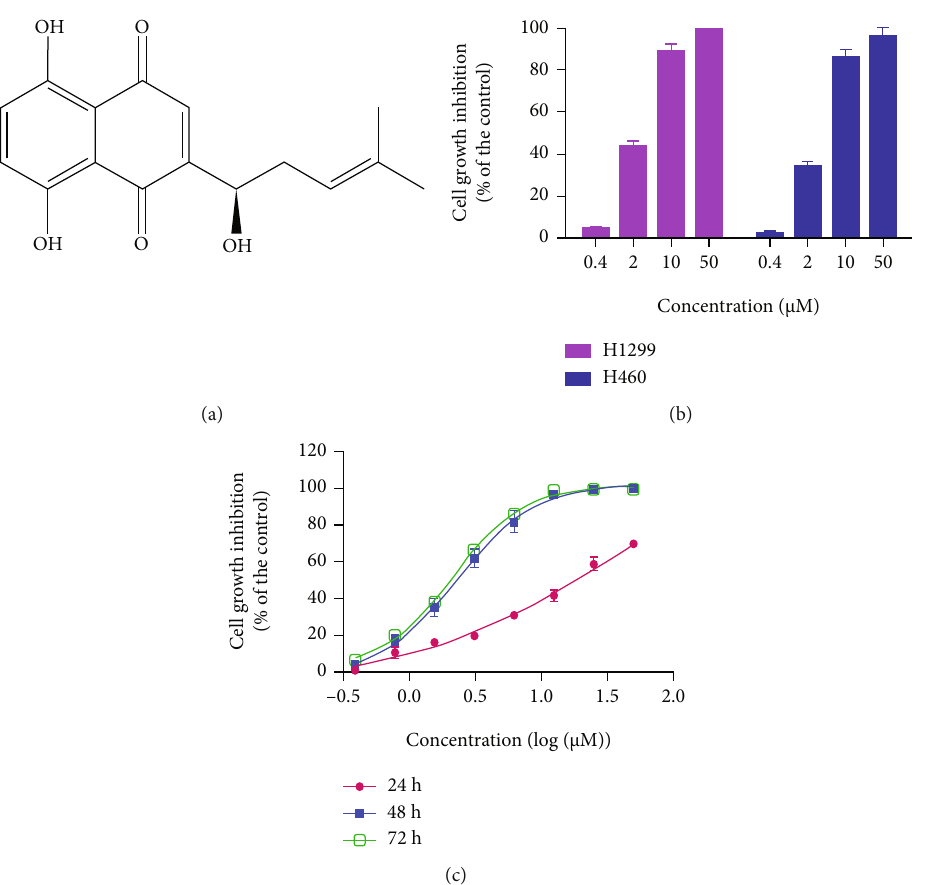
Figure 1: The e ff ect of shikonin on NSCLC cell growth: (a) chemical structure of shikonin; (b) e ff ect of shikonin on NSCLC cell (H1299 and H460) growth at 48h; (c) e ff ect of shikonin on H1299 cell growth at di ff erent time points. Cells treated with various concentrations of shikonin for 24, 48, and 72 h were measured by MTT assay. Five replicates for each treatment were done, and the data are presented as the mean ± standard errorof the mean from three repeated